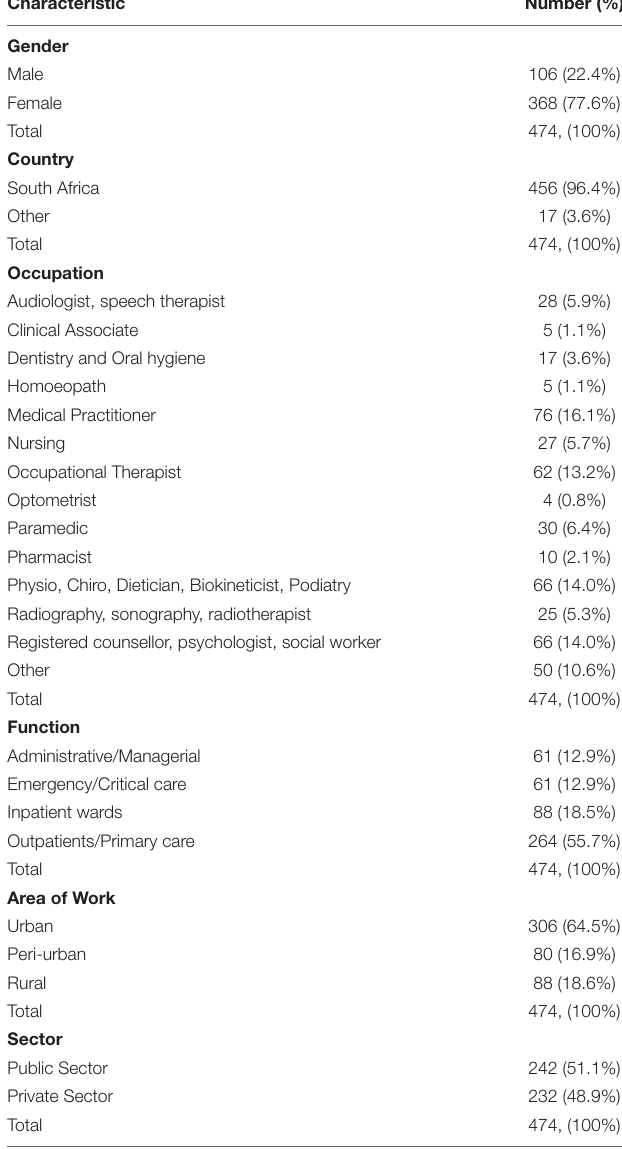
TABLE 1 | Participant